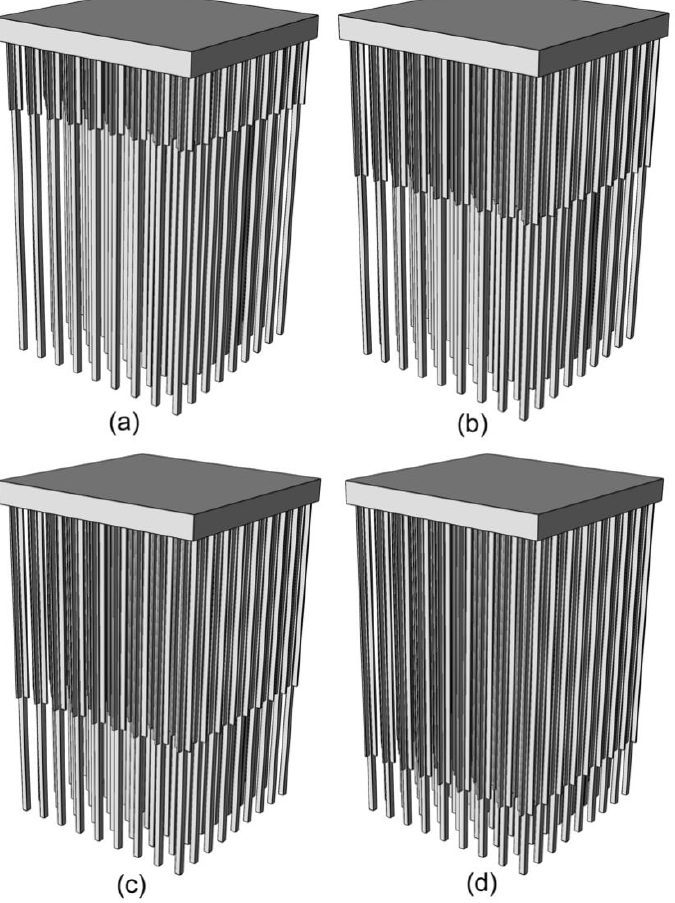
Figure 9. Three-dimensional finned pile-mats of varying fin-lengths (L f /L p ) used in the SSI analyses: ( a ) L f = 0.2L p ; ( b ) L f = 0.4L p ; ( c ) L f = 0.6L p ; and ( d ) L f = 0.8L p .